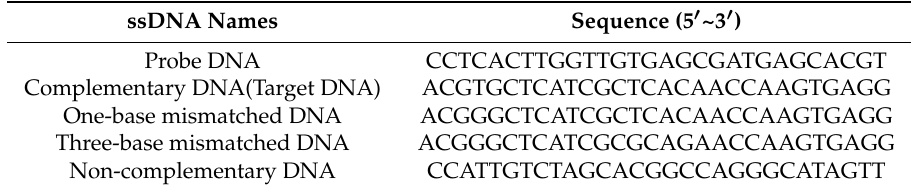
Table 1. Oligonucleotides employed in this